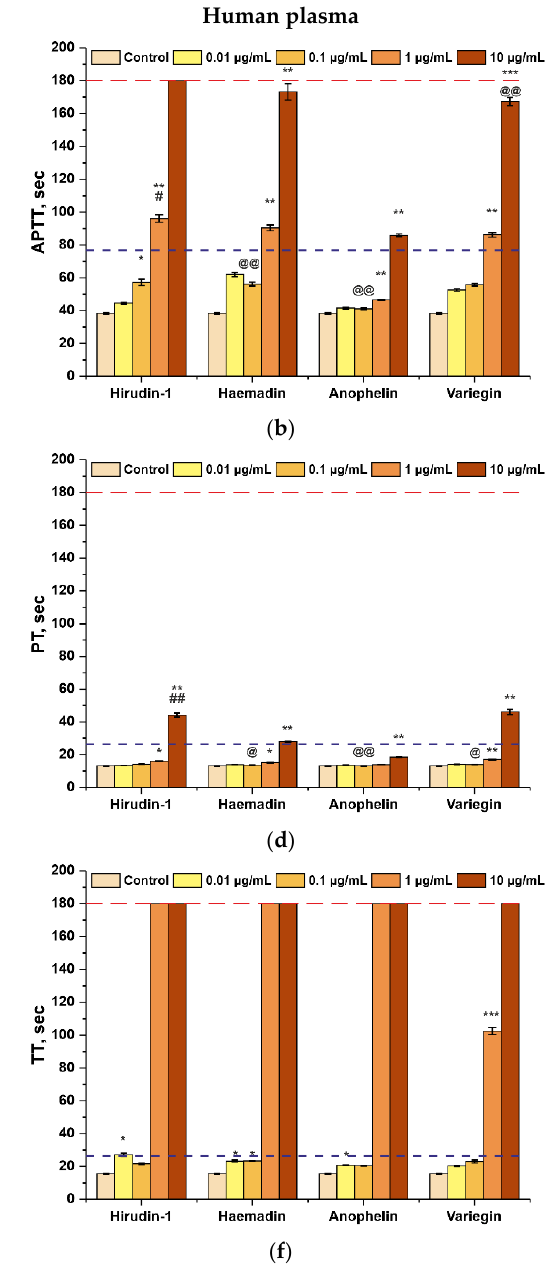
Figure 4. Results of the coagulation assays in mouse ( a , c , e ) and human ( b , d , f ) plasma. Effect of hirudin-1, anophelin, haemadin, and variegin on activated partial thromboplastin time (APTT) ( a , b ), prothrombin time (PT) ( c , d ), and thrombin time (TT) ( e , f ). All experiments were performed in five replications. Data are presented as the mean per group ± standard deviation. *** indicates p ≤ 0.001 compared to a Control (Saline), ** indicates p ≤ 0.01 compared to a control, and * indicates p ≤ 0.05 compared to a control according to a Kruskal–Wallis test; ## indicates p ≤ 0.01 compared to a concentration of 0.1 µ g/mL (for mice) and 0.01 µ g/mL (for humans) and # indicates p ≤ 0.05 compared to a concentration of 0.1 µ g/mL (for mice) and 0.01 µ g/mL (for humans) according to a Kruskal–Wallis test; @@ indicates p ≤ 0.01 compared to a concentration of 100 µ g/mL (for mice) and 10 µ g/mL (for humans) and @ indicates p ≤ 0.05 compared to a concentration of 100 µ g/mL (for mice) and 10 µ g/mL (for humans)according to a Kruskal–Wallis test. The blue dotted line indicates a 50% increase in the value relative to the control (saline). The red dotted line indicates the time limit for measuring the values of coagulation parameters (180